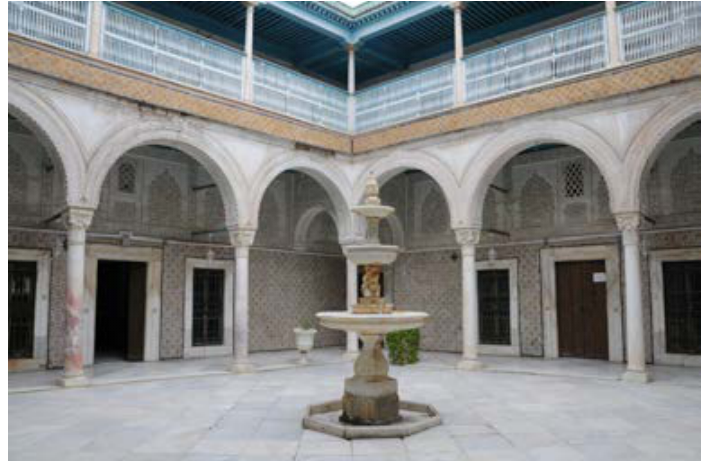
Figure 13. Dar BenAbdallah, Tunis (Riadmisbah, n.d.)